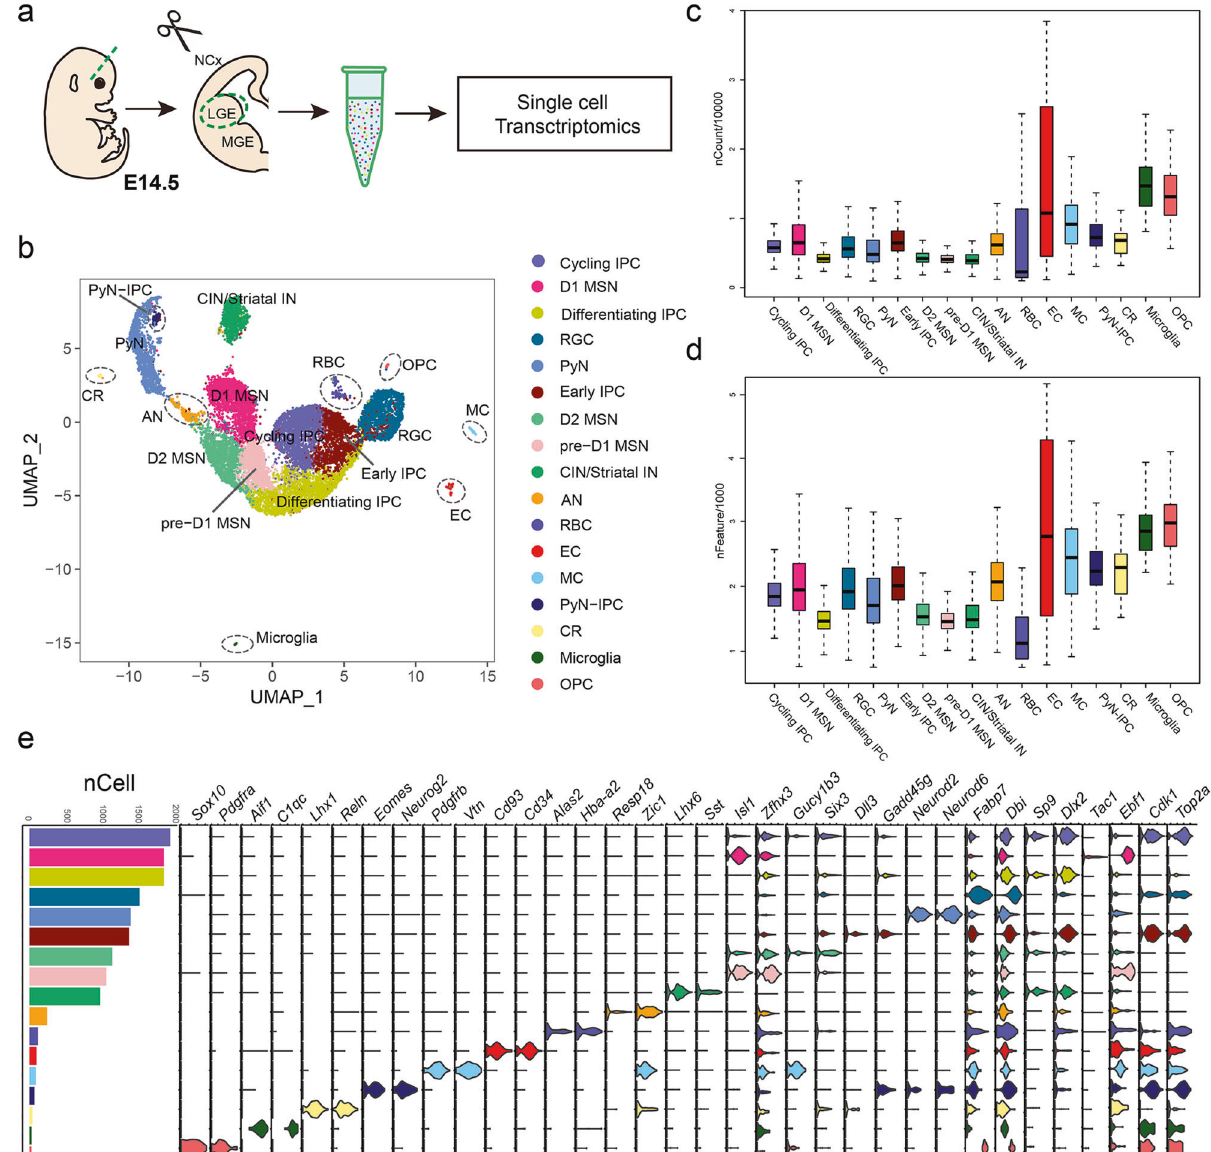
Fig. 1 Single-cell transcriptome delineates mouse lateral ganglionic eminence cellular heterogeneity. a Schematic view of the experimental work fl ow. b Cellular composition of the lateral ganglionic eminence (LGE) was visualized using UMAP, and seventeen clusters were identi fi ed and annotated. Individual single-cell transcriptomes were colored on the basis of cluster identity. c , d Boxplots showed the number of unique molecular identi fi ers (UMIs, nCounts) per cluster (scale is in ten thousand) and the number of genes (nFeatures) detected per cluster (scale is in thousands). e Graph showed the number of cells per cluster. Violin plots depicted the expression of cell-type-speci fi c marker genes for each cluster. Individual clusters was colored on the basis of cluster identity as shown in b . IN: interneurons, AN: amygdala neurons, RBC: red blood cells, EC: ependymal cells, MC: mural cells, CR: Cajal-Retzius